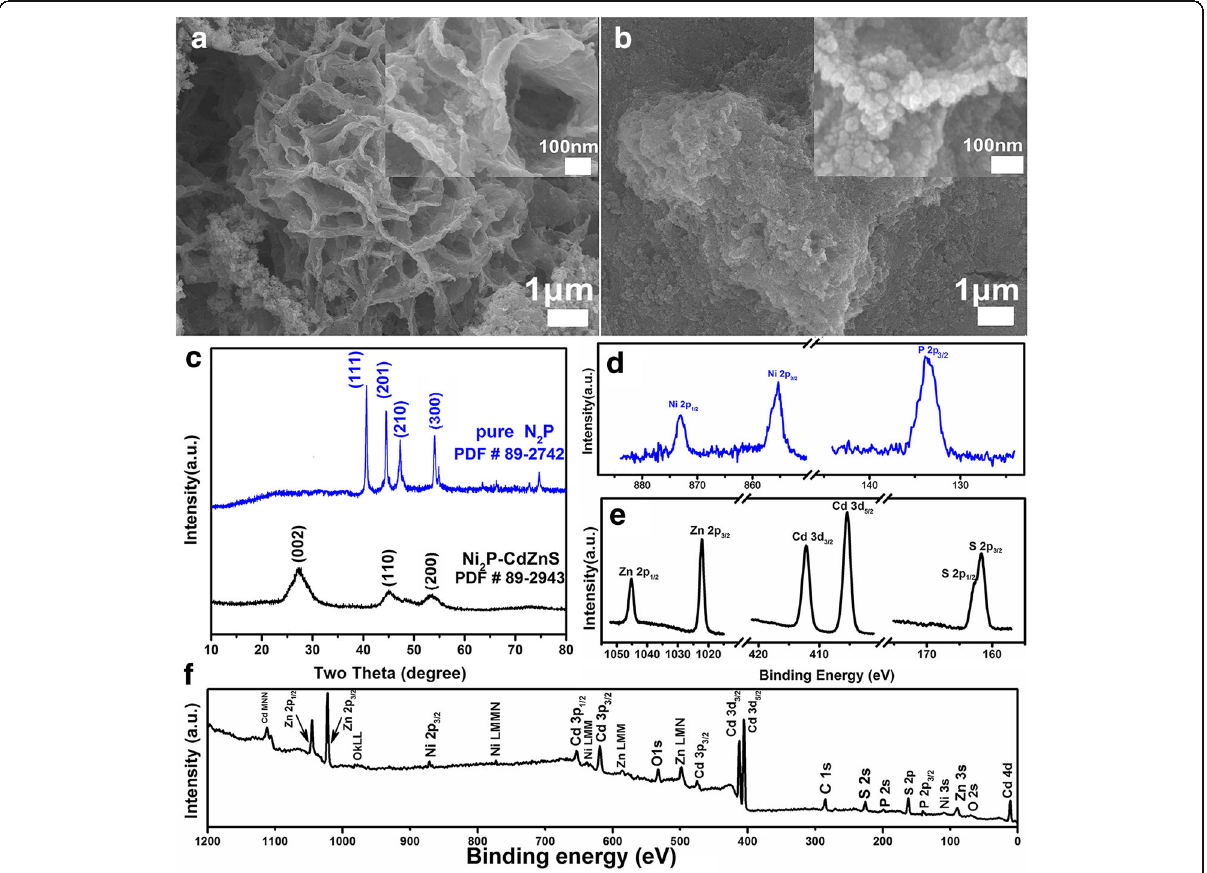
Fig. 1 Morphology, crystalline property, and chemical states of Ni 2 P-Cd 0.5 Zn 0.5 S composites (1.5 wt% Ni 2 P). a – b Low and high (inset) magnification SEM images of Ni 2 P before and after the loading of Cd 0.5 Zn 0.5 S, c XRD pattern of Ni 2 P and Ni 2 P-Cd 0.5 Zn 0.5 S, d – f XPS fine and survey spectra of Ni 2 P-Cd 0.5 Zn 0.5 S